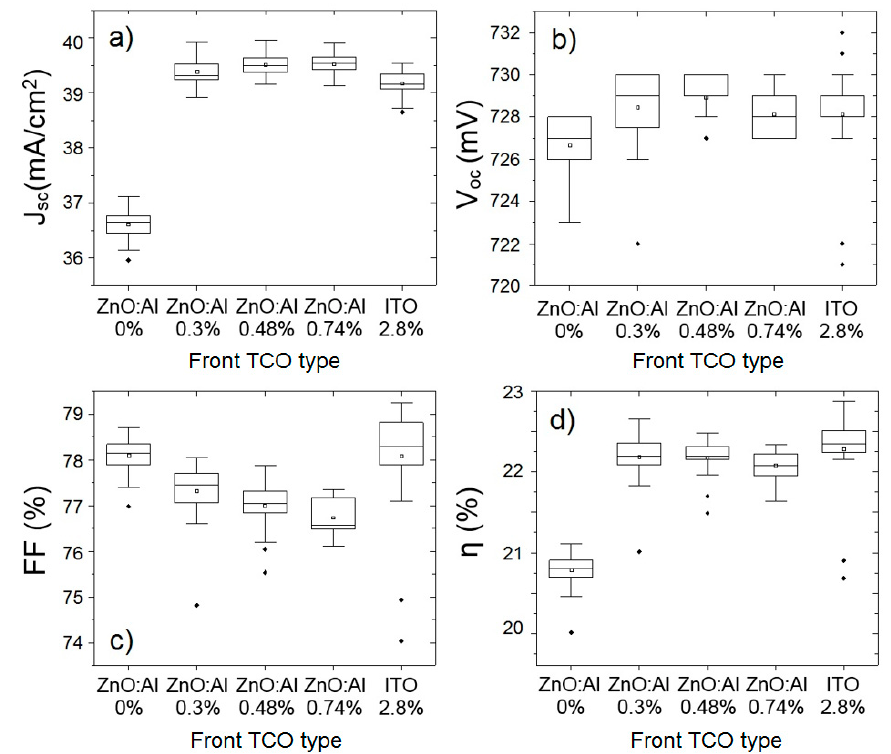
Figure 5. ( a ) j sc , ( b ) V oc , ( c ) FF and ( d ) η for the bifacial ZnO:Al solar cells and the ITO reference. The box plots represent the statistics of the measurements made on the two wafers with 14 cells each. The horizontal axis of each graph shows the material used in that group as a front TCO and the partial oxygen flow under which this material was deposited.